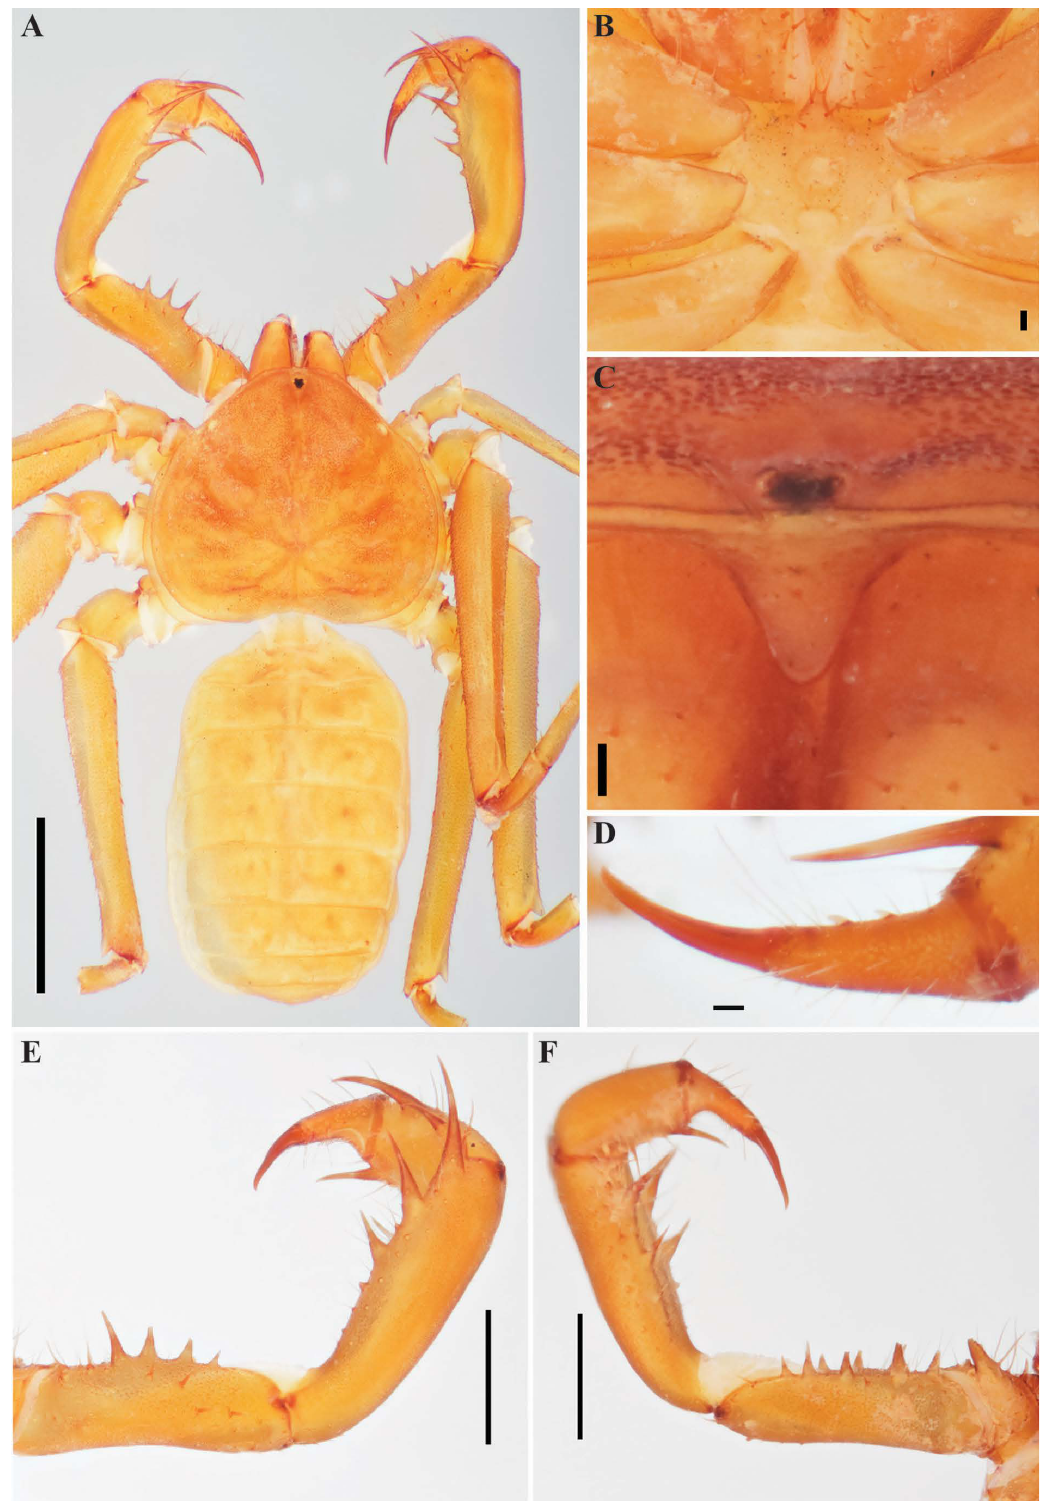
Fig. 136. Sarax abbatei (Delle Cave, 1986) comb. nov. (MZUF 1896–167), general morphology, ♀. A . Habitus, dorsal view. B . Sternum, ventral view. C . Frontal process. D . Pedipalp tarsus, frontal view. E . Pedipalp, dorsal view. F . Pedipalp, ventral view. Scale bars: A, E–F = 1 mm; B–D = 0.1